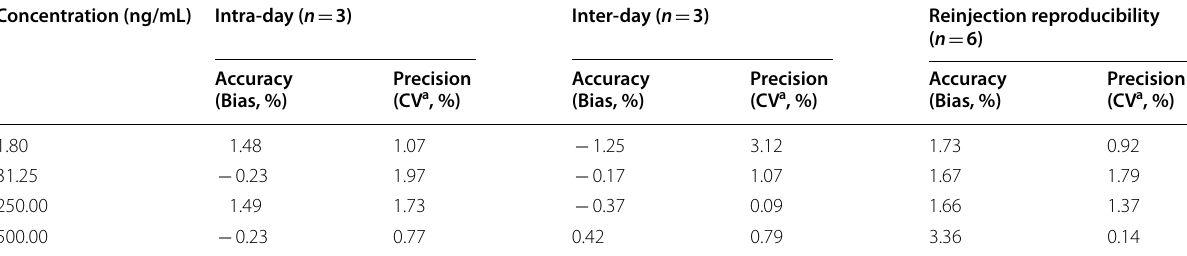
a CV Coefficient of variation